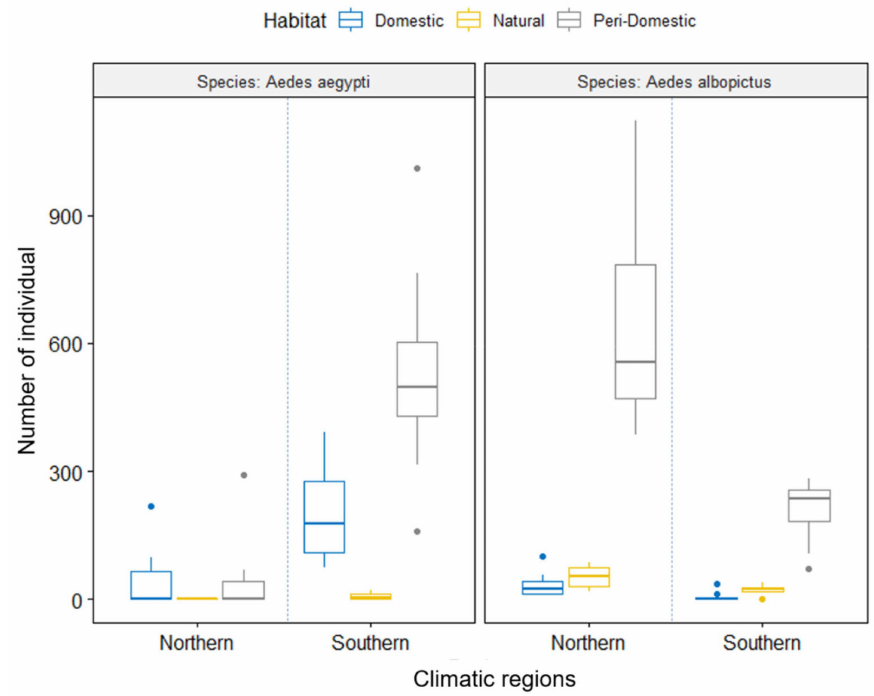
Figure 3. Effects of habitat and region on the abundance of Ae. aegypti and Ae. albopictus (multi-way ANOVA). Color circles are indicated for outlier